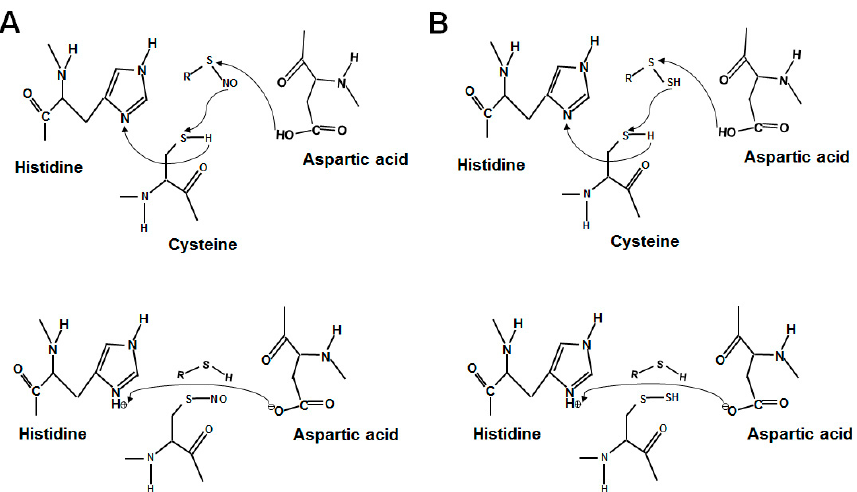
Figure 1. The proposed forming mechanisms of protein S -nitrosylation and S -sulfhydration